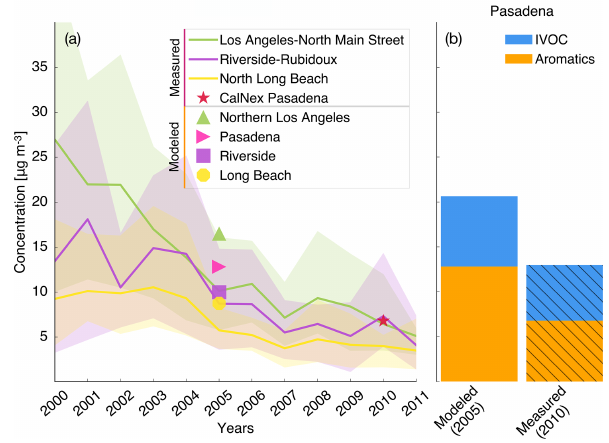
Figure 7. (a) Mass concentrations of single-ring aromatics in south- ern California at different sites between 2000 and 2011. Measure- ments show the temporal trend in the summertime mean (solid line) and 10th–90th percentile (bands) at Los Angeles, Riverside, and Long Beach from 2000 to 2011 (ARB, 2017) as well as the campaign-averaged measurement from CalNex at the Pasadena ground site in 2010 (Zhao et al., 2014). Model predictions show the 14-day-averaged concentration simulated in this work at four different sites (solid symbols) in 2005. (b) Mass concentrations of single-ring aromatics and IVOCs compared between the model pre- dictions from 2005 (this work) and measurements in 2010 (Zhao et al.,